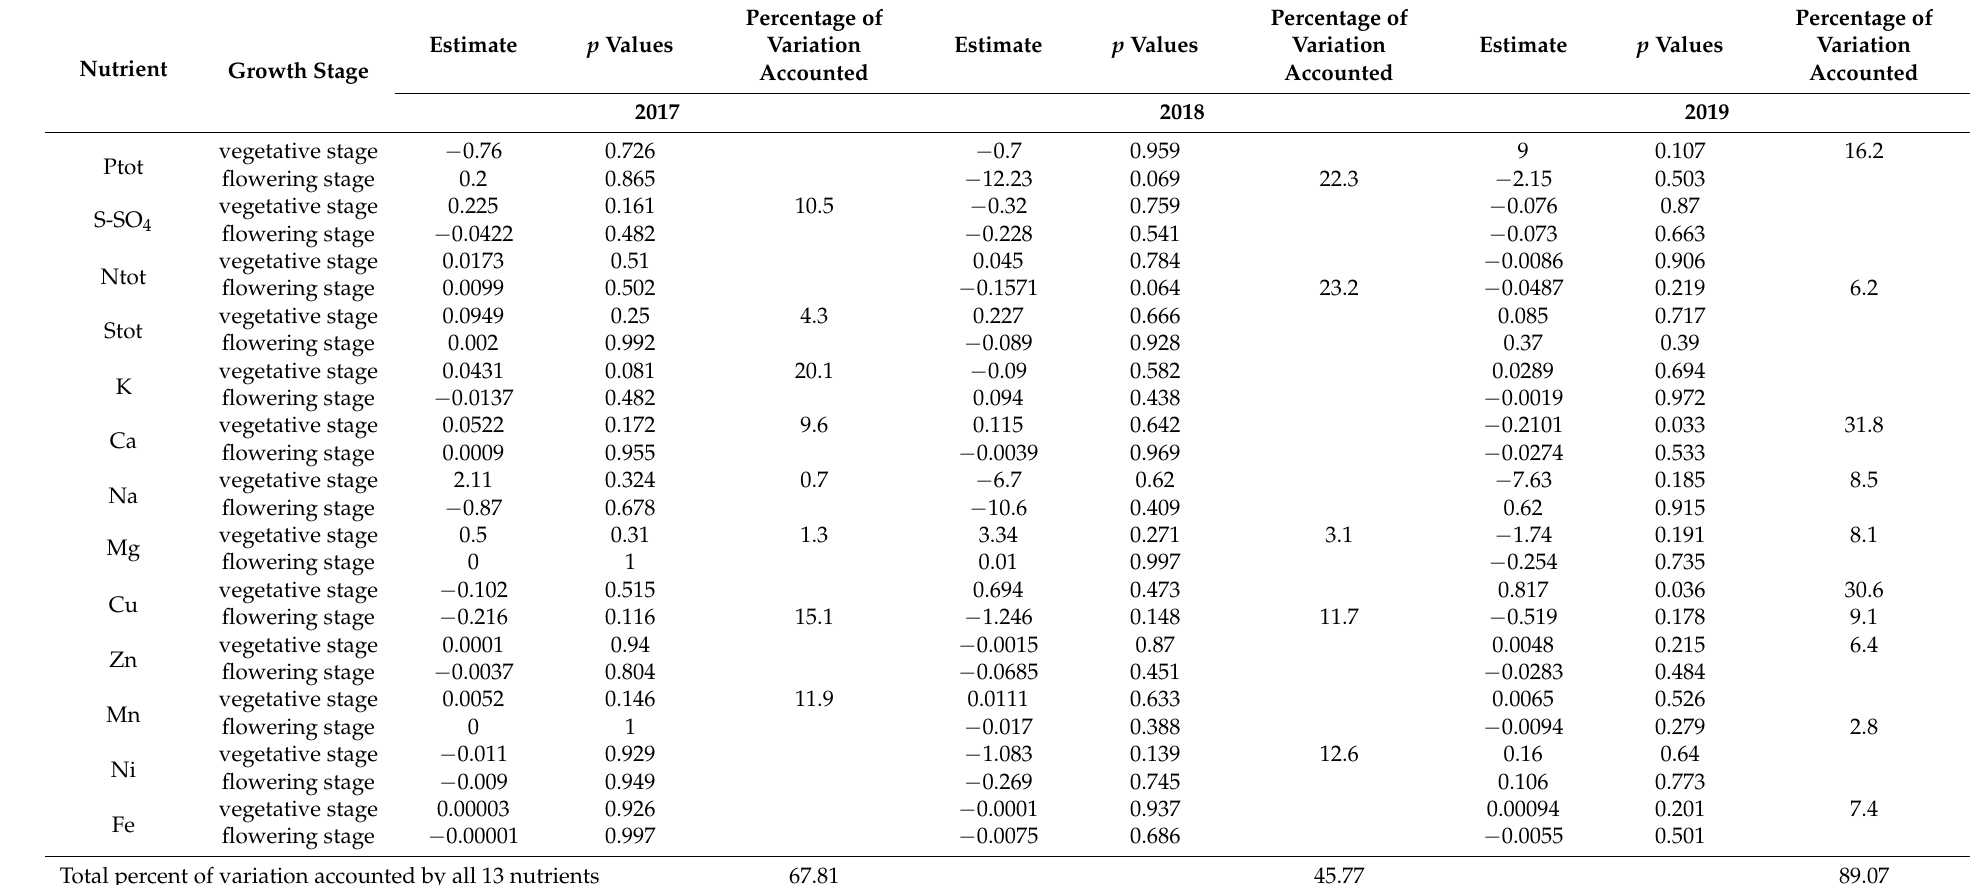
Table 7. The associations between the analyzed nutrients and resistance to Brevicoryne brassicae (N =